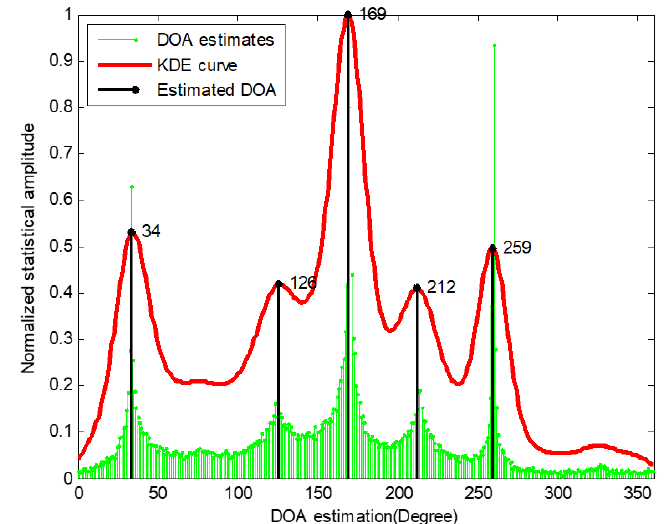
Figure 1. Normalized amplitude DOA estimation histogram of seven sources.